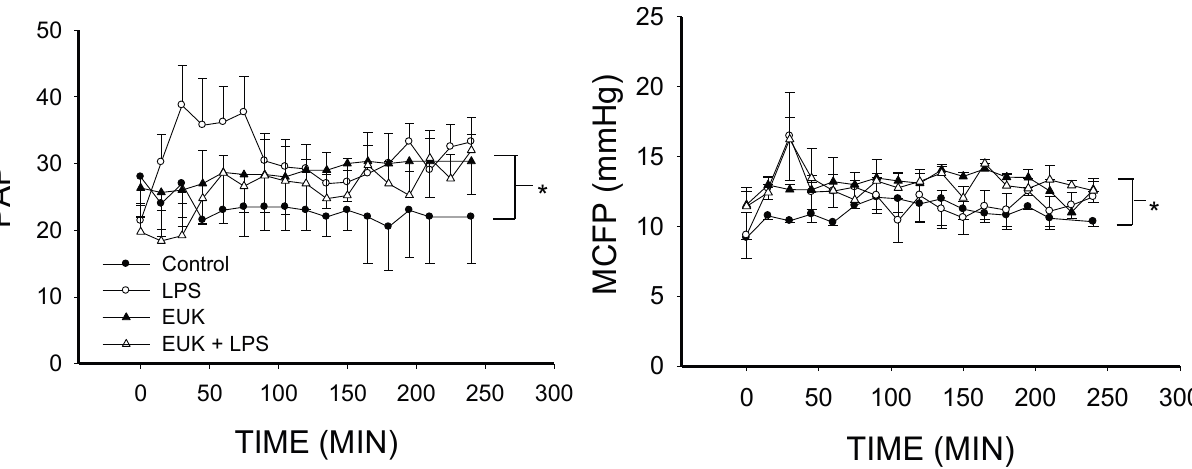
Figure 3. Pulmonary artery pressure (PAP) and mean circulatory filling pressure (MCFP) over time for the four conditions (mean ± SEM). Left , PAP in the LPS group was higher than control ( p < 0.001). LPS plus EUK-134 ( p < 0.001) and EUK alone ( p < 0.02) were higher than the control but were not significantly different from each other. LPS plus EUK-134 was lower than LPS alone; Right , MCFP in LPS was not different from control although there appeared to be a “spike” in the pressure that was also seen with LPS plus EUK-134 and had the same timing as the rise in PAP. MCFP was greater in the EUK-134 alone group than in the control ( p < 0.003) and LPS plus EUK-134 ( p < 0.003). MCFP of the LPS plus EUK-134 group was greater than that of LPS ( p < 0.014). * p < 0.02, 0.005 or